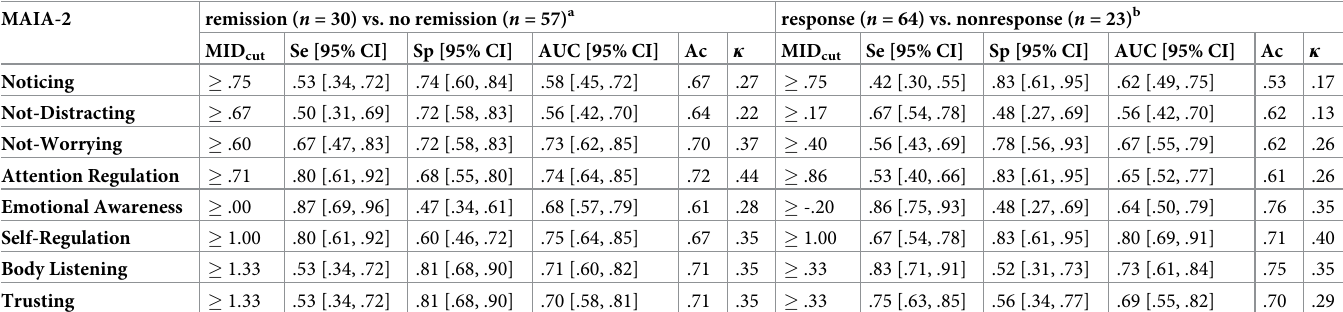
between � -.20 (Emotional Awareness) and � 1.00 (Self-Regulation) for treatment response, respectively. Except for the Noticing and Not-Distracting scales, the AUCs were significantly different from .50 implicating non-random classifiers. The agreement between dichotomized clinical outcome (remission/response) and ROC classification predicted from cut-points was reasonable ( κ � .20) except for the treatment response vs. nonresponse groups on the Noticing and Not-Distracting scales ( κ < .20). The best agreement was found for Attention Regulation ( κ = .44) regarding achievement of remission and for Self-Regulation ( κ = .40) regarding response to treatment. Table 7. Cut-points for MAIA-2 scales determined by ROC curve analyses ( n = 87).